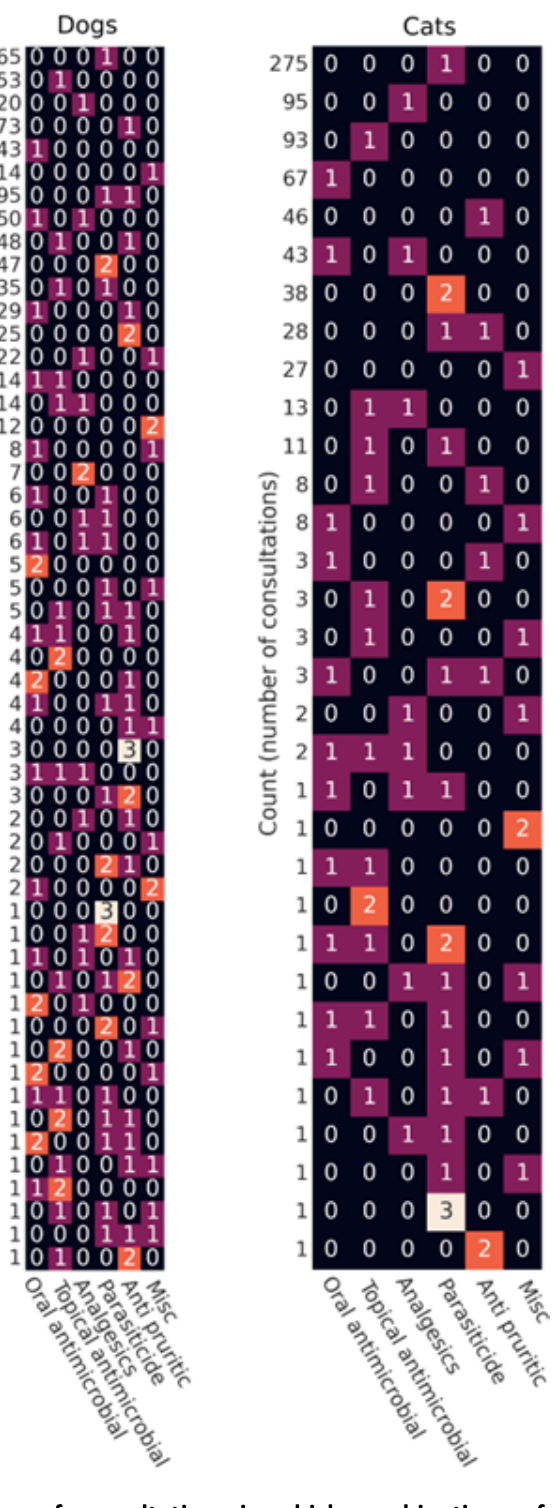
Figure 4: Counts of the number of consultations in which combinations of POM-V / POMs falling into product broad classification were prescribed Medication broad classifications included oral antimicrobials, topicals containing antimicrobials, analgesics, parasiticides, antipruritics and other / miscellaneous.